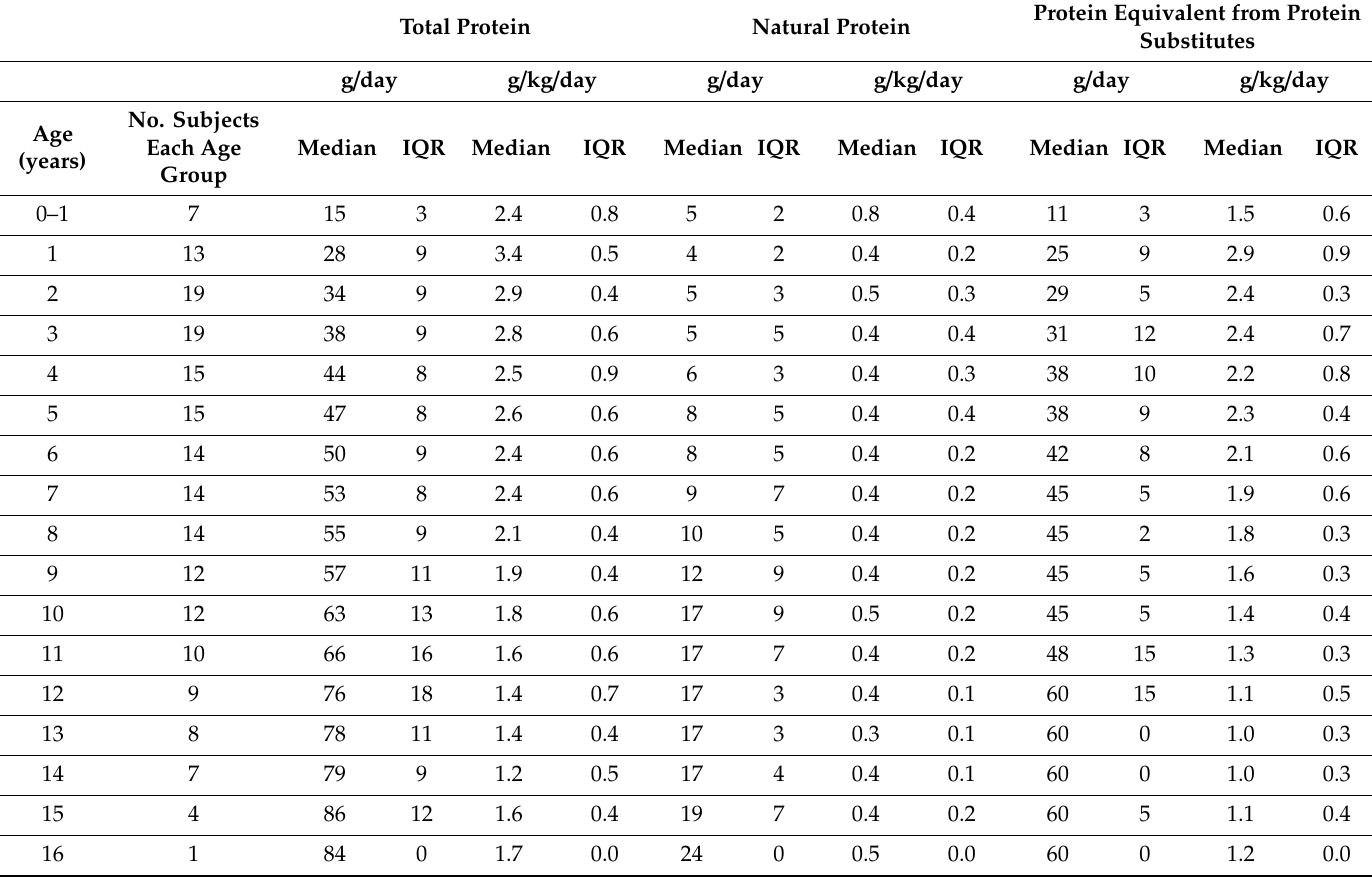
Table 2. The median amounts of total protein, natural protein (NP) and protein equivalent intake from protein substitutes prescribed by